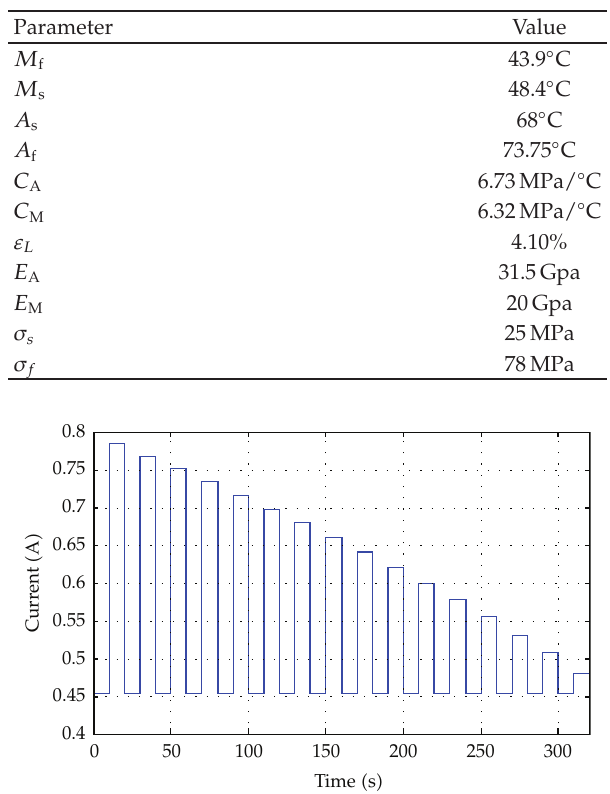
Table 2: Physical parameters of SMA wire actuator.